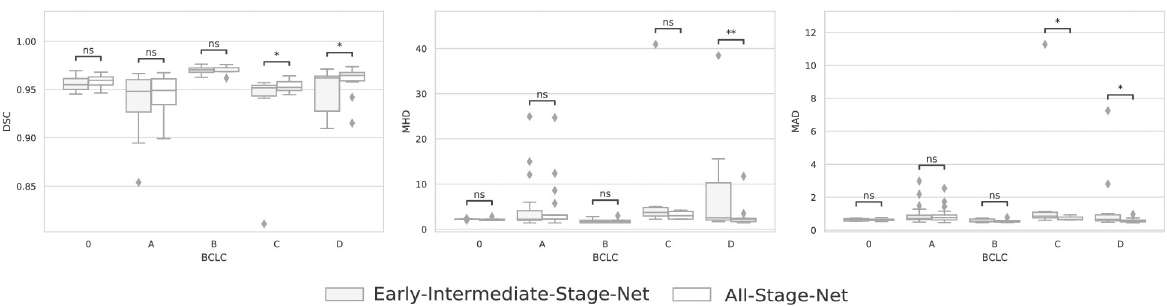
Fig 5. Liver segmentation method performance across different Barcelona Clinic Liver Cancer (BCLC) cancer stages. The automatic liver segmentations of the Early-Intermediate-Stage-Net (EIS-Net) and All-Stage-Net (AS-Net) were compared quantitatively against the experts’ manual segmentations by means of the Dice Similarity Coefficient (DSC), Modified Hausdorff Distance (MHD), and Mean Absolute Distance (MAD). AS-Net showed better mean performance, fewer outliers and better worst-case performance across all segmentation metrics indicating a more robust segmentation performance. A Wilcoxon signed-rank test was used for pairwise comparisons between the liver segmentation algorithms and a p-value < 0.05 was considered statistically significant (denoted with � , ns denotes no significant differences).